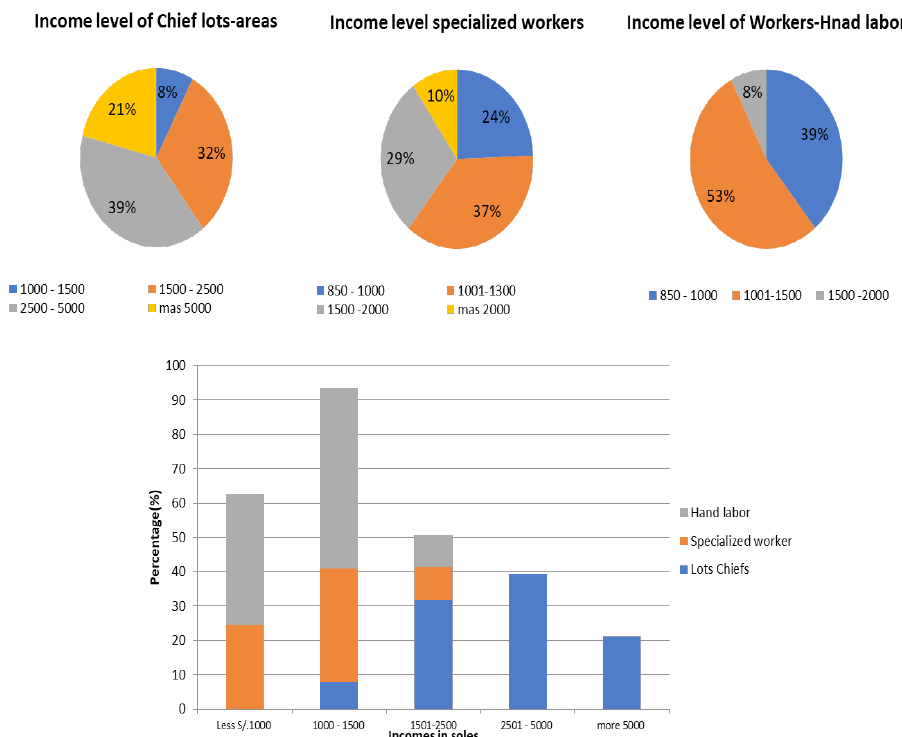
Figure 16. Income level in Peruvian nuevos soles of the different types of workers of asparagus and avocado farms of the Chavimochic irrigation project in